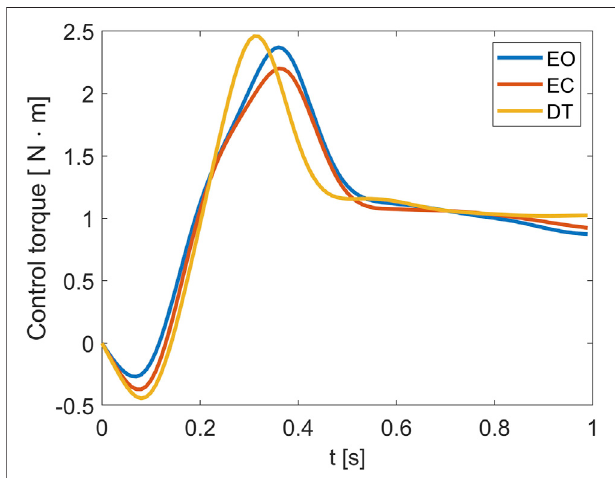
FIGURE 2 | Control torque τ c ( t ) for a representative subject measured in the three experimental